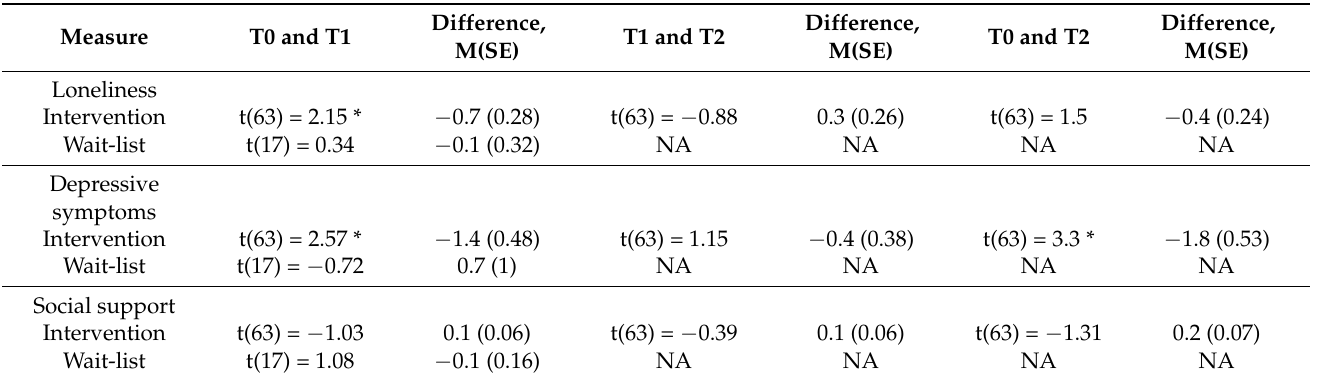
Table 3. The results of t tests between T0 and T1, and T1 and T2, and the overall differences between T0 and T2 for intervention and wait-list control groups